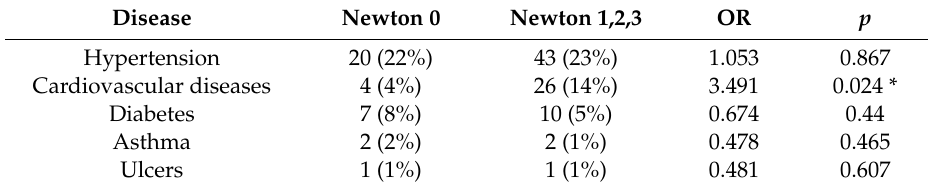
Table 4. The health status of the Newton group 0 patients who qualified for treatment compared with the group of patients in whom symptoms of inflammation were visible—Newton 1, 2 and